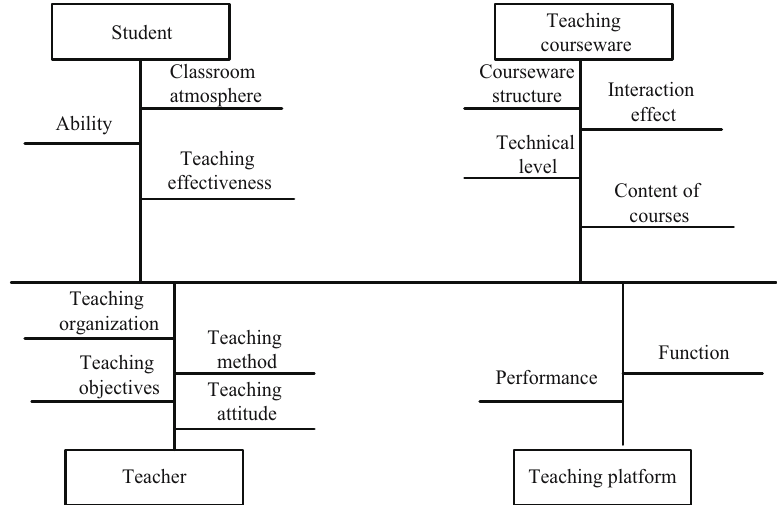
Figure 1: Evaluation index model of multimedia